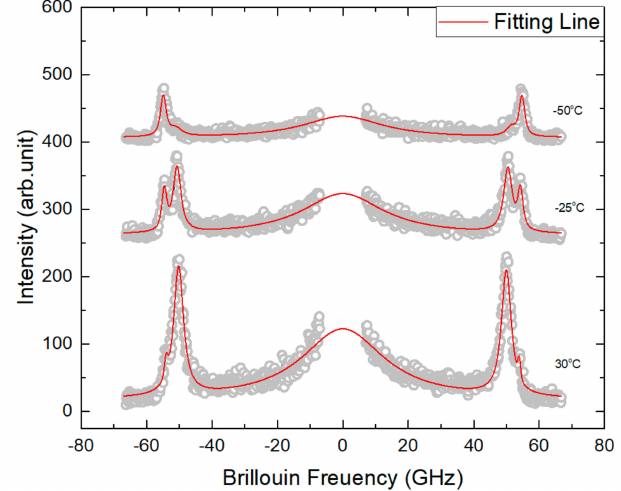
Figure 4. Temperature dependence of the Brillouin spectrum of NBT- x BT with x = 5% prepoled at room temperature under 1.4 kV/mm. The phonon propagation direction is along the <100> direction.